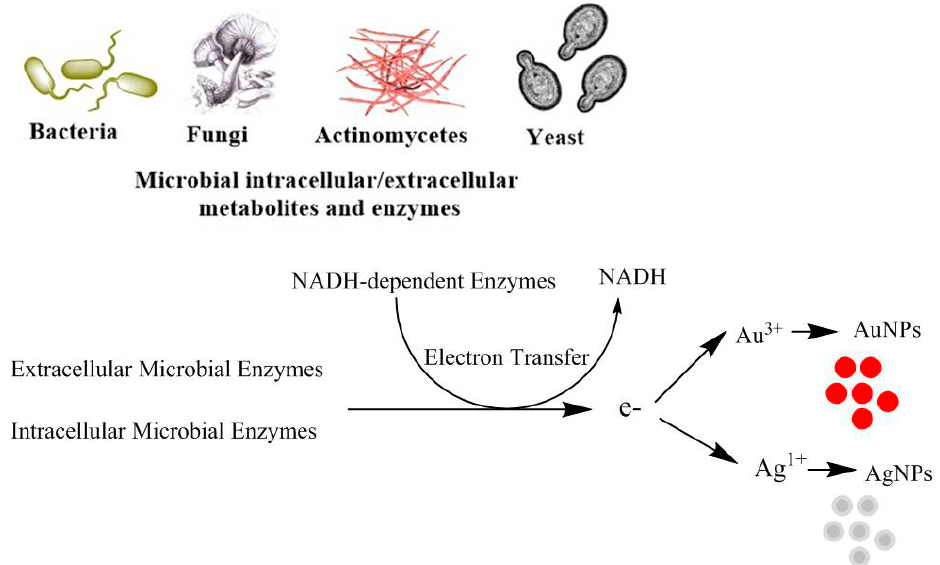
Figure 1. Role of NADH and NADH-dependent microbial enzymes in the synthesis of metal nanoparticles (MtNPs).